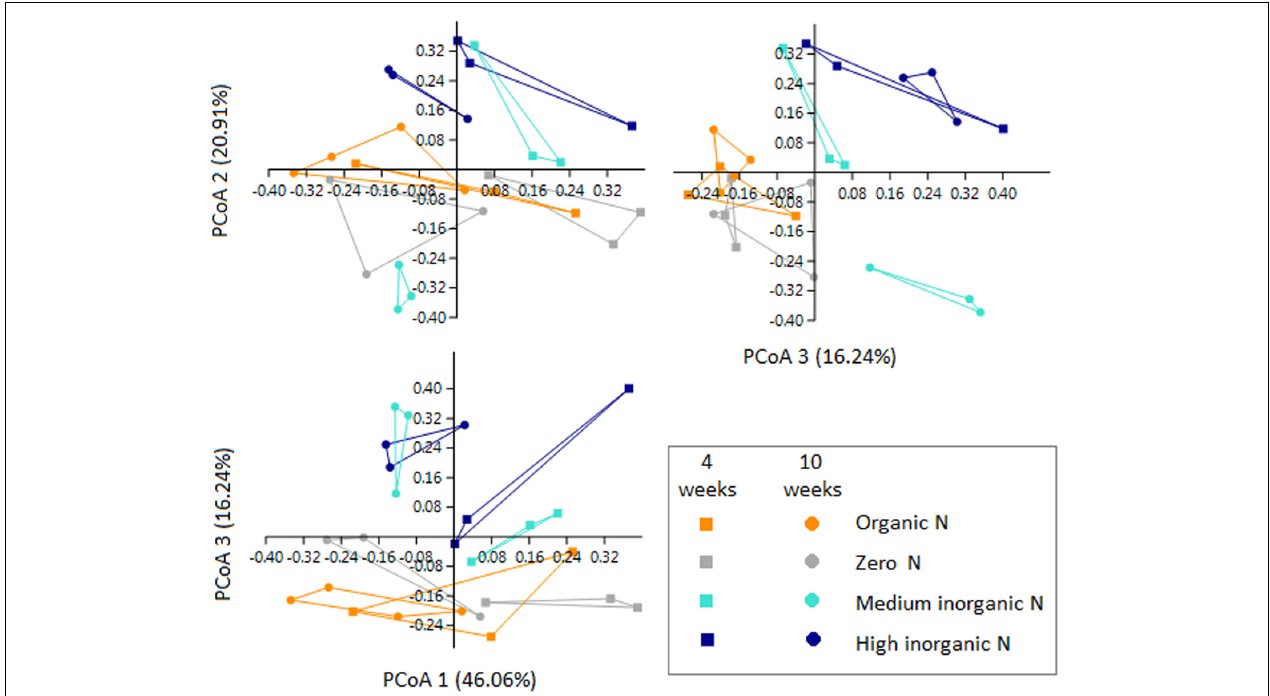
FIGURE 6 | PCoA plots based on 16S rRNA gene-predicted functions for rhizosphere bacterial communities of wheat grown in soils under different fertilization (orange = organic N, gray = zero N, turquoise = medium inorganic N, and dark blue = high inorganic N), collected at two stages (4 and 10 weeks). Squares represent samples collected after 4 weeks and circles represent samples collected after 10